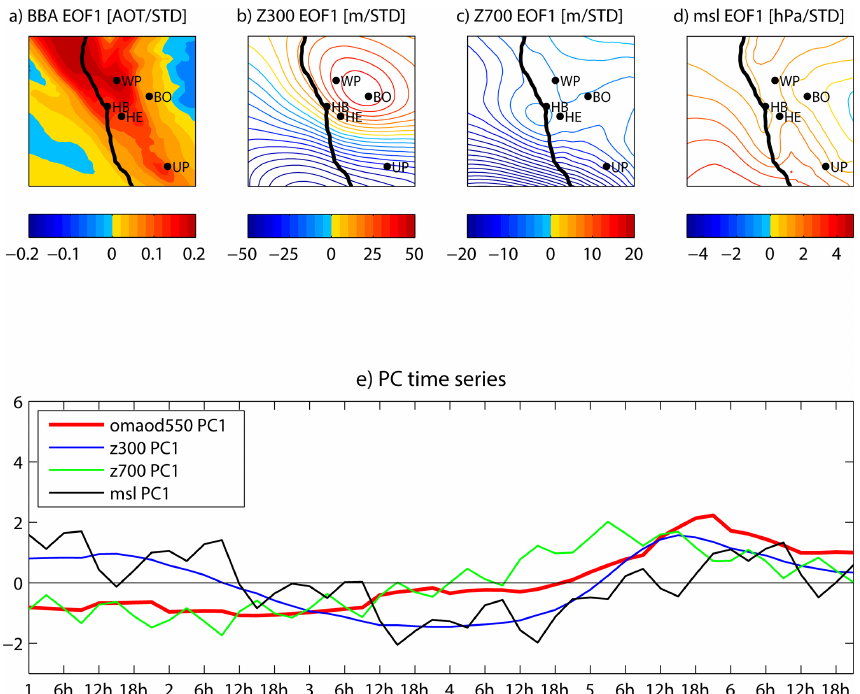
Figure 5. Principal component analysis (PCA) of CAMS BBA and atmospheric circulation above Namibia from 1 to 6 September 2017. In panels (a) – (d) the anomaly patterns associated with the first mode of variability of (a) organic matter AOT at 550nm, geopotential height at (b) 300hPa and (c) 700hPa and (d) MSLP are obtained by regressing raw data onto the PCA time series displayed in panel (e) . Anomaly patterns display anomalies per standard deviation (SD). The 12h oscillation seen in the time series of the MSLP and the geopotential at 700hPa is a tidal effect, typical of the Earth’s atmosphere (Chapman and Lindzen,